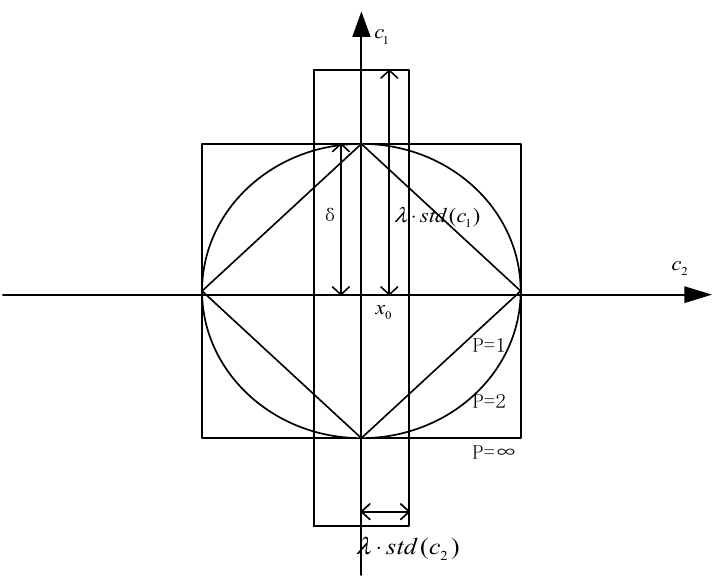
Figure 2. Neighborhoods of x 0 in terms of different